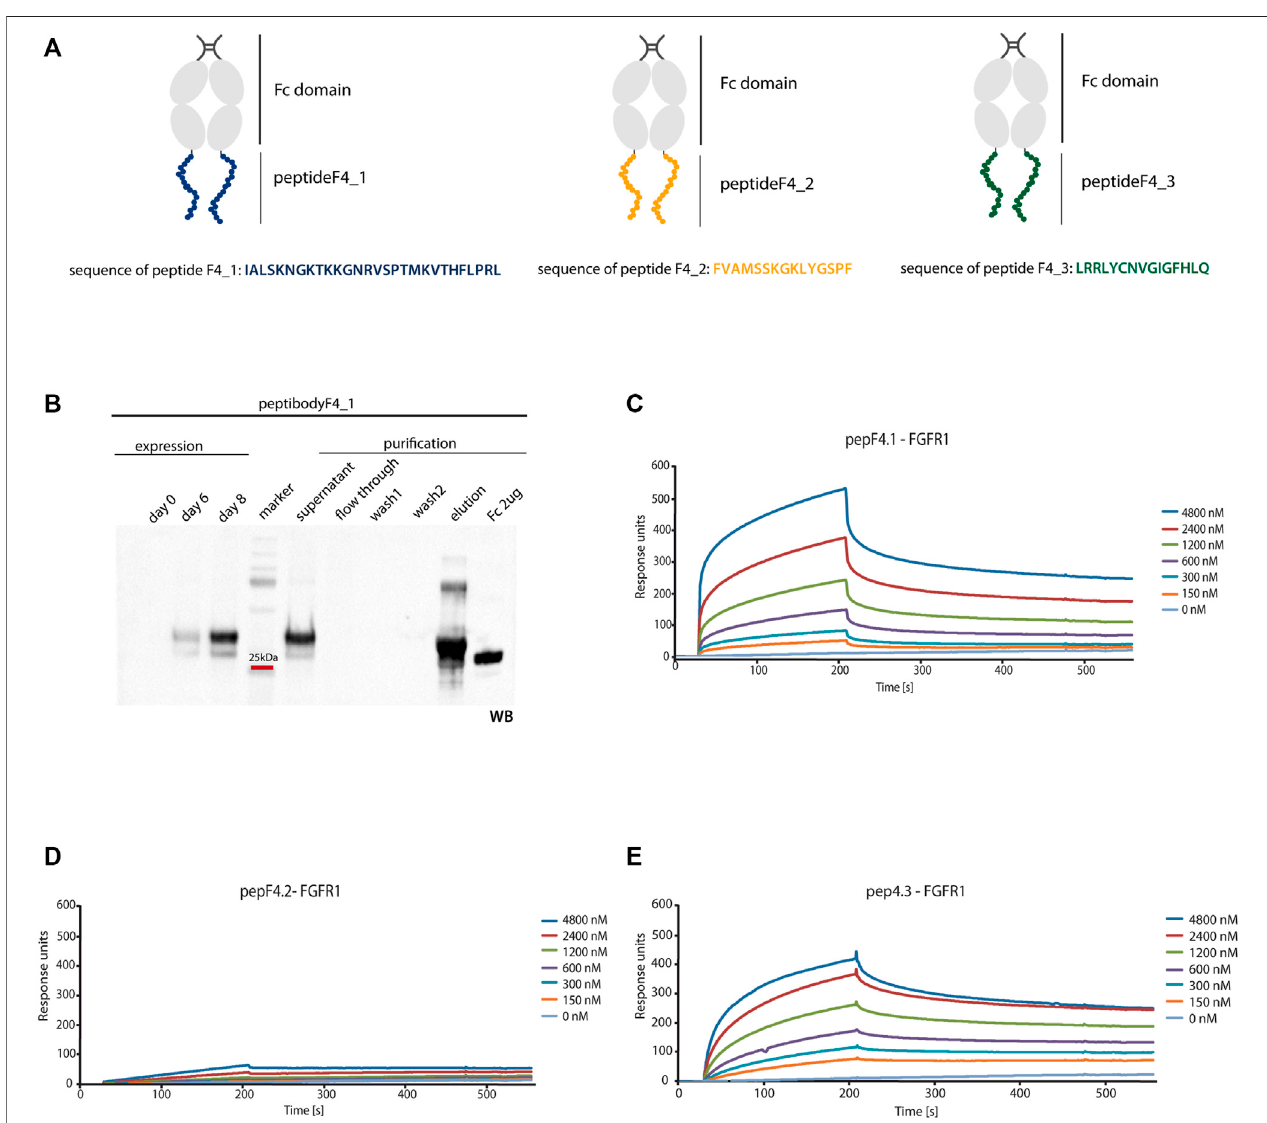
FIGURE 3 | FGFR1 binding of generated peptibodies. (A) Scheme representing the Fc C-terminal fusion with new FGFR1-binding peptides identi fi ed from FGF4 sequence.PeptideF4_1ismarkedinblue,peptideF4_2inorange,peptideF4_3ingreen,andFcdomainingray. (B) PeptibodieswereoverexpressedinCHO-Scellsand puri fi ed byaf fi nity chromatographyon ProteinA-resin. Detection ofpeptibodywas carried out bywestern blotting using antibody recognizing the Fcdomain.Exampleof expression and puri fi cation process Western blot analysis is presented for peptibodyF4_1. (C – E) SPR measurements determined the af fi nity of peptibodies to FGFR1. FGFR1 was immobilized on SPR sensors and incubated with different concentrations of peptibodyF4_1 (C) , peptibodyF4_2 (D) , and peptibodyF4_3 (E) . K D values determined for peptibodyF4_1 and peptibodyF4_3 were 2.99 × 10 − 6 M and 1.09 × 10 − 6 M, respectively. PeptibodyF4_2 did not show measurable FGFR1